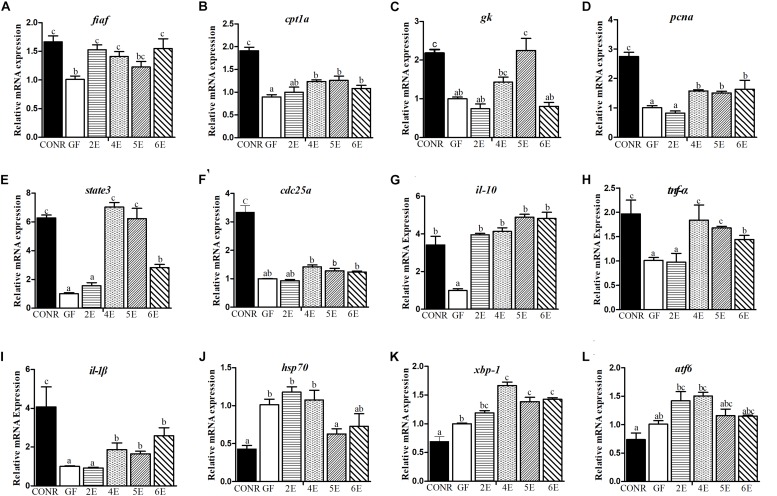
Comparisons of gene expression levels among germ-free (GF) zebrafish, CONR zebrafish and mono-associated (GF) zebrafish with different concentrations of E. coli DH5α. (A) The expression levels of nutrients metabolism related genes fiaf, (B)
cpt1a, (C)
gk.
(D) The expression level of cell proliferation related genes, pcna, (E)
state3, (F)
cdc25a.
(G) The expression levels of innate immune related genes il-10, (H)
tnf-α and (I)
il-1β. (J) The expression levels of damage stress related genes hsp70, (K)
xbp1 and (L)
atf6. The results were shown as mean ± SEM of three independent experiments with six replicates for each experiment, n = 90, per group. Different letters indicate statistically significant differences among groups (p < 0.05).